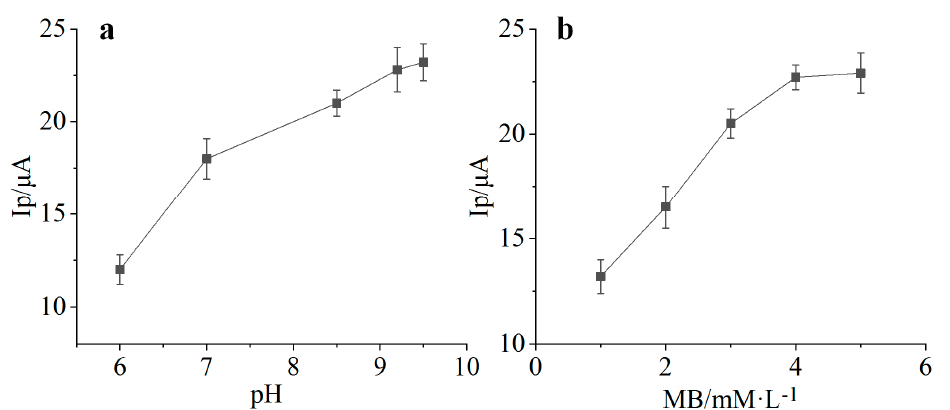
Figure 4. Effects of pH and MB concentration on electrochemical polymerization. Electropolymerization experiments were carried out in different MB buffer solutions. The concentration of MB was fixed at 5 mM, and the pH of the solution was adjusted to 6, 7, 8.5, 9.1 and 9.5, respectively ( a ). The concentration of MB ranged from 1 to 5 mM under pH 9.2 condition ( b ) ( n = 3).